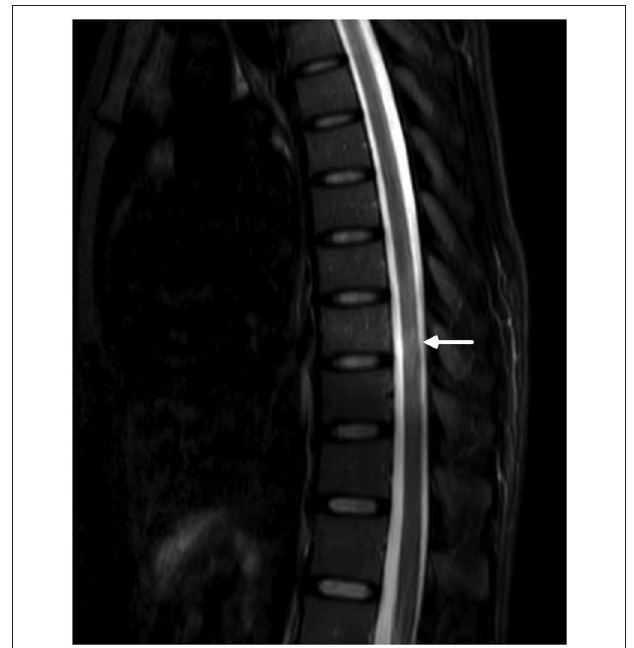
FIGURE 2 | MRI of the lower thoracic spine showed T2 hyperintense lesions from T7 through T9 (arrow). However, the signal was blurry, and we considered it to be